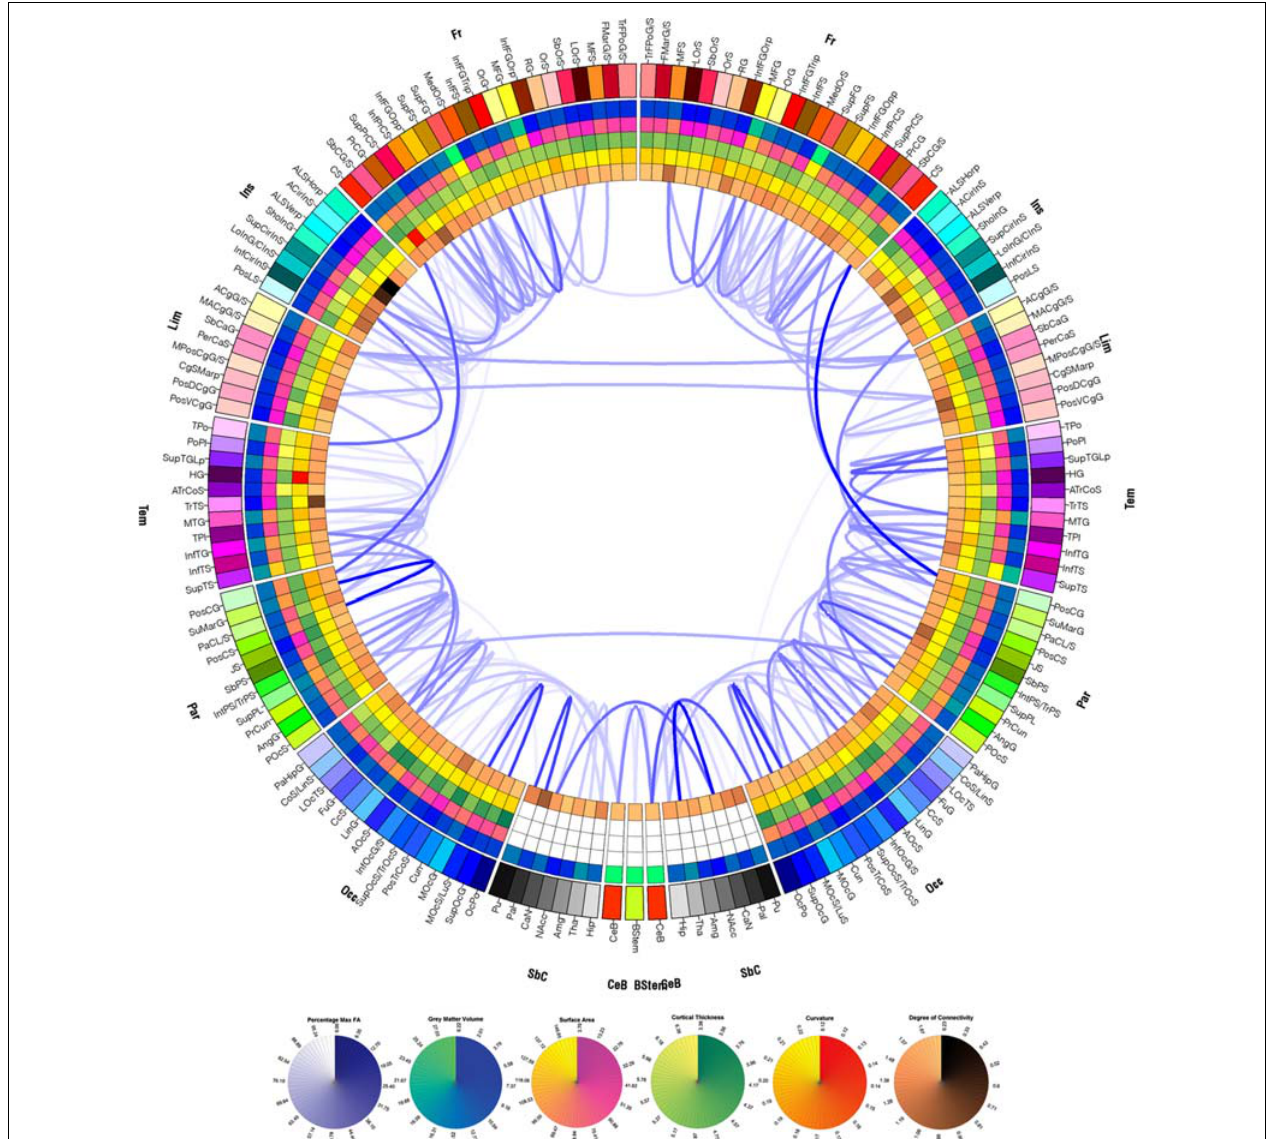
thickness, curvature, and degree of connectivity. A link of variable opacity is drawn between certain pairs of brain parcels, reflecting structural connectivity properties between regions. In the case of the connectogram displayed, links displayed indicate connections which suffered from large atrophy from the acute baseline to the chronic follow-up time point. Link transparency encodes the percentage change (cid:2) in fiber density, in the range [min( (cid:2) ), max( (cid:2) )], with larger changes (more negative values of (cid:2) ) being encoded by more opaque hues of blue.The lowest color opacity corresponds to the smallest absolute value of the percentage change which is greater than the selected threshold of 30%, and the highest opacity corresponds to the maximum absolute value of the change in fiber density. See Irimia etal. (2012a) for